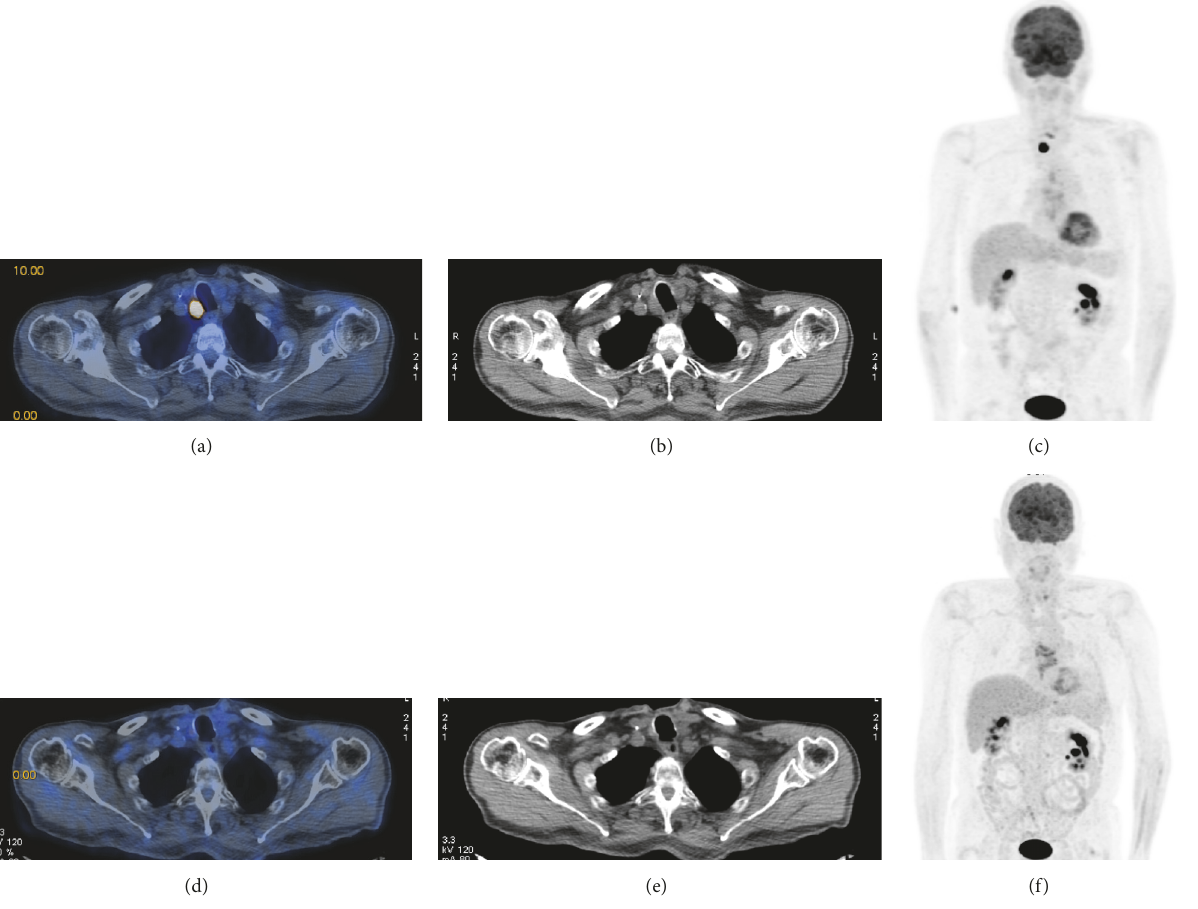
Figure 1: 79-year-old man with metastasis ahead the trachea from classic variant PTC previously treated with surgery and RAI. (a, b, c) Pre-EBRT focal uptake (19mm × 18mm) shown with 18 F FDG PET/CT (SUVmax 6.5), CT, and MIP-scan images, respectively. (d, e, f) Disappearance of the lesion showed with post-EBRT 18 F FDG PET/CT, CT, and MIP-scan images,